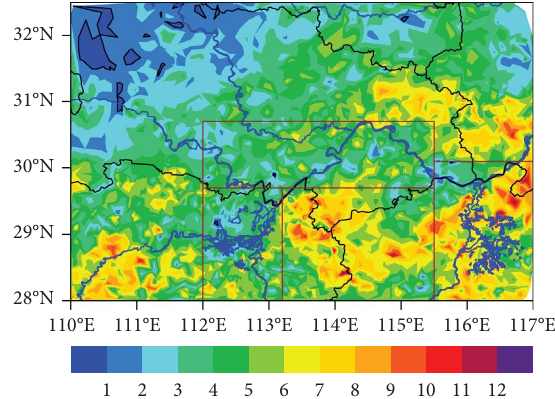
Figure 2: Annual average distribution of the HHR frequency in the middle YRV from April to October 2012-2017. Te brown lines indicate partitions, the same as Figure